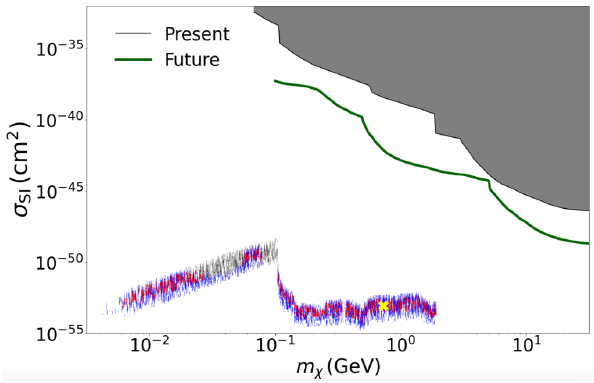
Figure 6 . The prediction of the scalar dark matter model obtained by casting the favored parame- ter sets in section 3.5 onto the plane of the dark matter mass and the SI scattering cross-section with C hχχ = 0. The colors used for the prediction are the same as those used in figures 4 and 5, except the gray points that indicate the parameter sets excluded by the collider dark matter detection in fig- ure 5. The constraint from present direct dark matter detection experiments and expected sensitiv- ities from future experiments are shown as a gray-shaded region and a dark-green line,